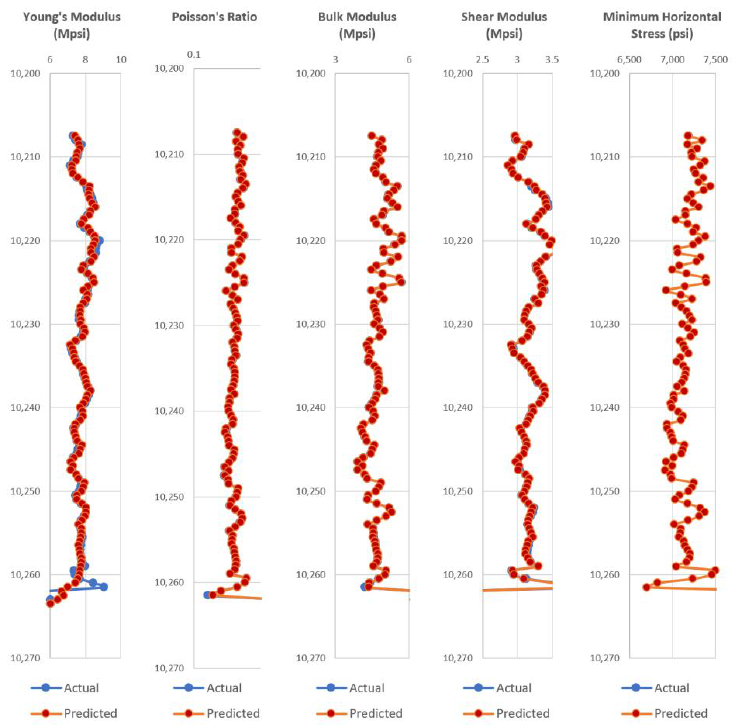
Figure A7. Actual and predicted geomechanical properties along with depth (feet) for test well 4 in Williams County for the Upper Bakken Shale. Energies 2018 , 11 , x FOR PEER REVIEW